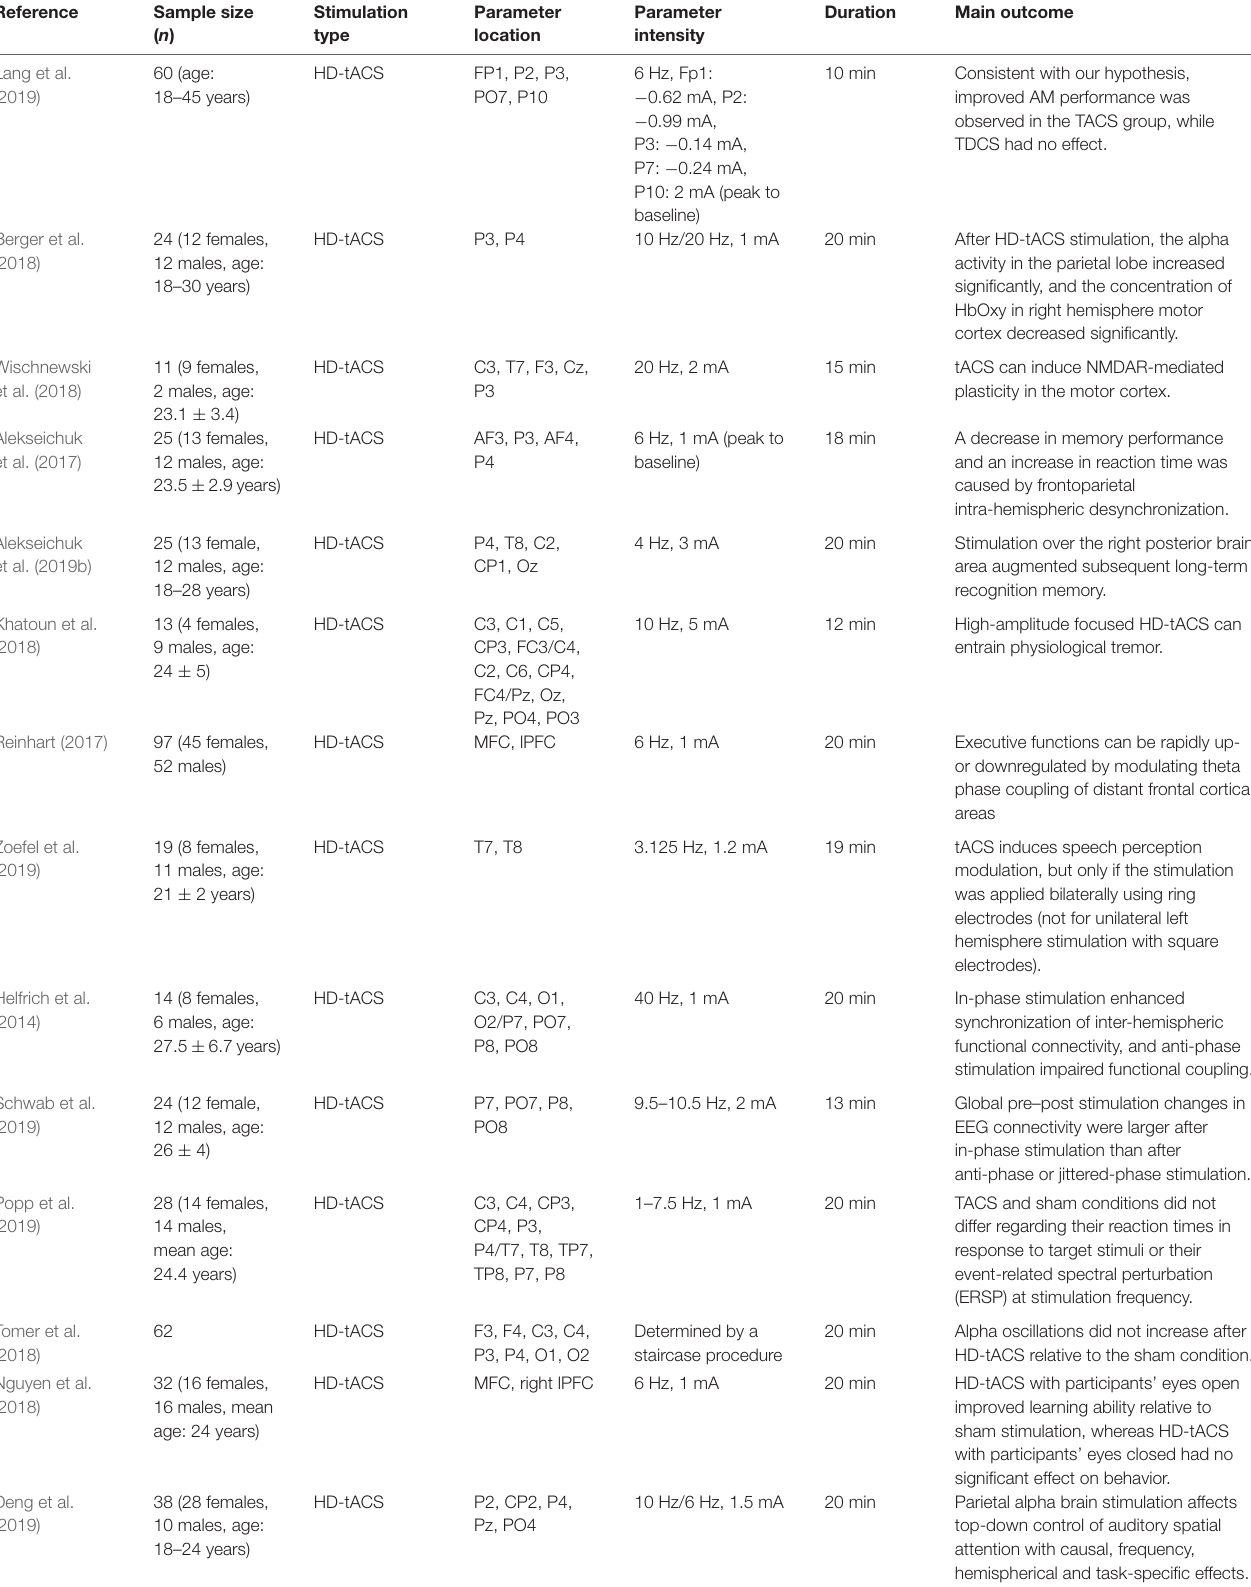
TABLE 1 | High-definition electrical